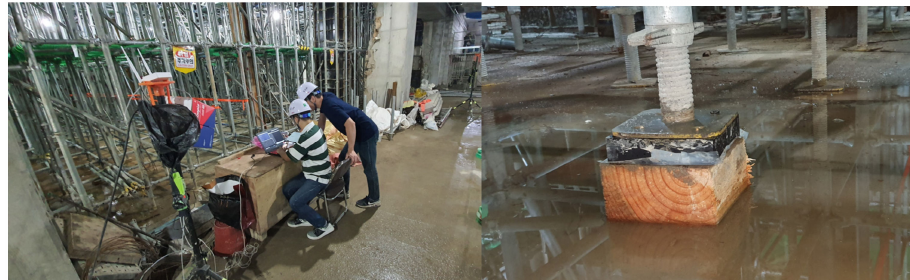
Figure 23. Field application of the Bluetooth load measurement monitoring